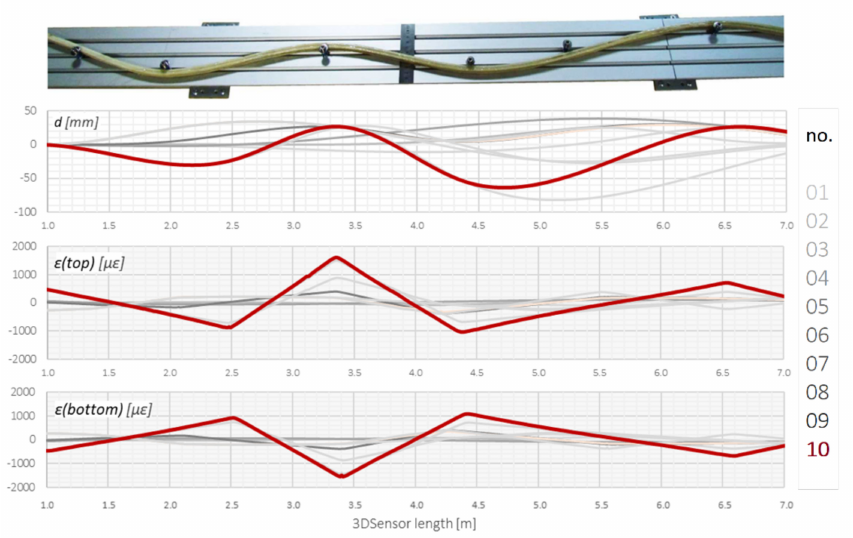
Figure 19. Example strain (top and bottom) and displacement data for continuous beam static scheme during subsequent configurations (01–10).